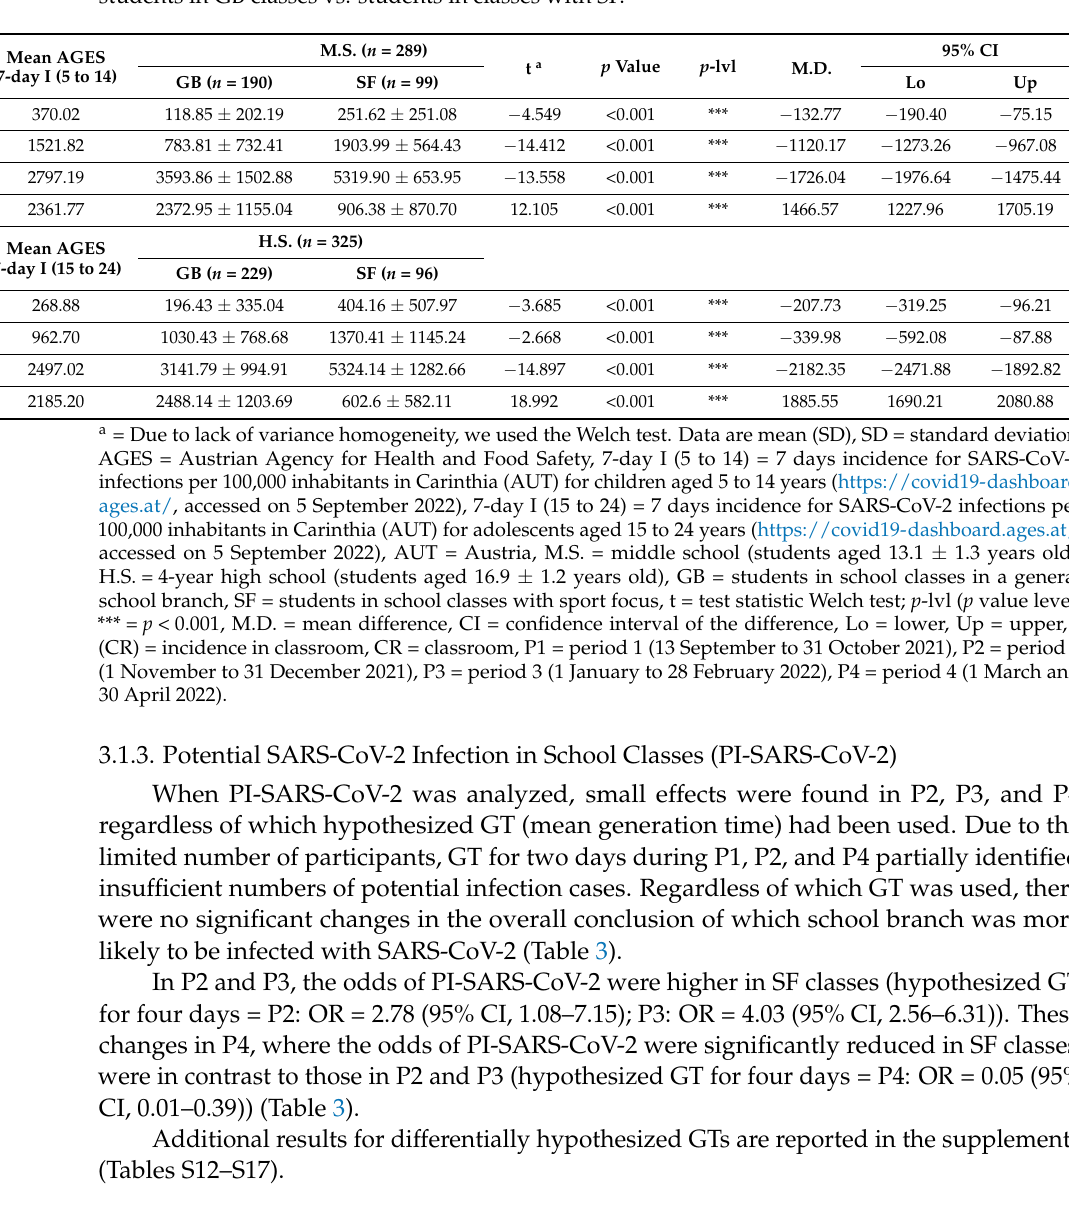
Table 2. Mean 7-day incidences in classrooms for SARS-CoV-2 infections per 100,000 inhabitants: students in GB classes vs. students in classes with SF.